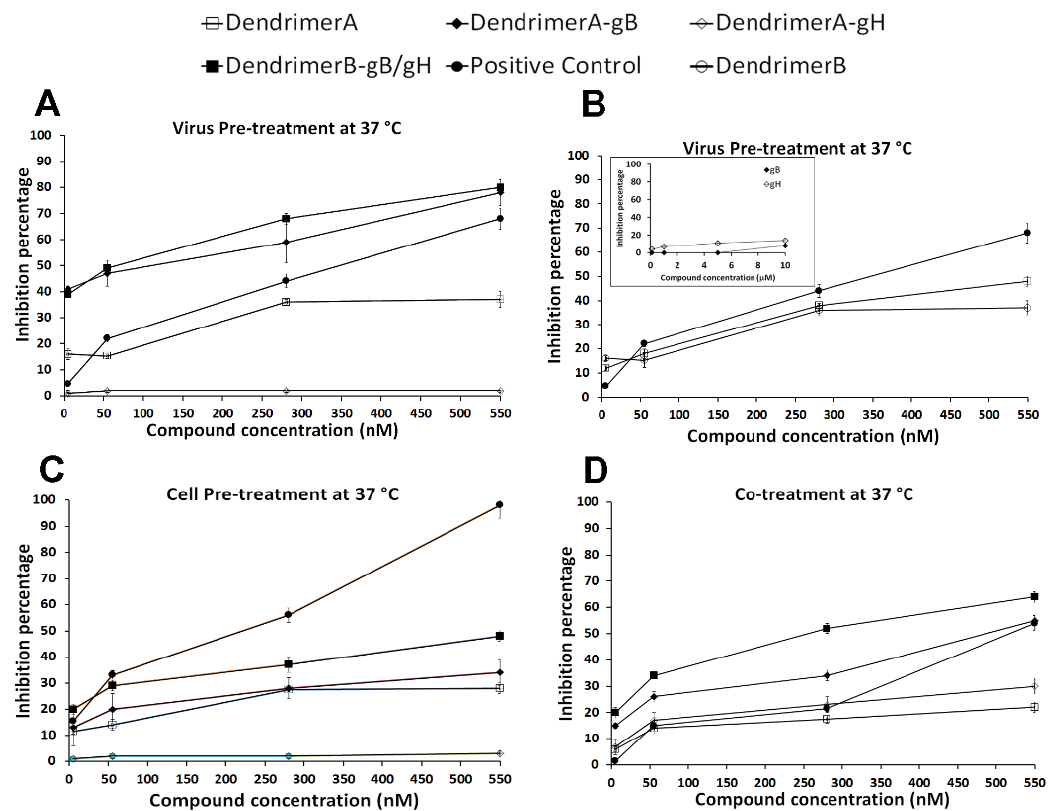
Figure 6. The virus was pre-incubated with compounds for 1 h at 37 ◦ C prior to the addition to the cells (Virus Pre-Treatment, panels A and B ). Cells were exposed to compounds either prior to infection (Cell Pre-treatment, panel C ) or during attachment and entry (Co-treatment, panel D ). The control is melittin in virus pre-treatment and co-treatment, and is dextran sulphate in cell pretreatment. Experiments were performed in triplicate, and the percentages of inhibition were calculated with respect to no-compound control experiments. Error bars represent standard deviations.